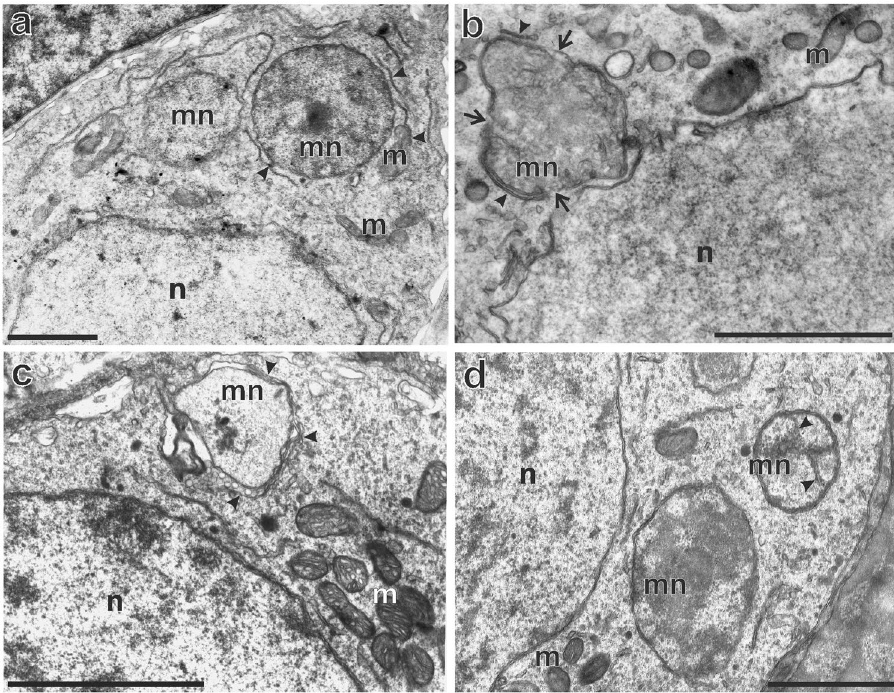
Figure 6. Chromatin in micronuclei is degraded by autophagy. Transmission electron microscopy analysis of autophagosome formation around micronuclei and invasion of tubular membranes inside the chromatin territory. Micronuclei were found in diploid hybrid males ( a ) and females ( b – d ) during the premetamorphosis stage of somatic development according to Gosner (1960), ( a – d ) stages 37, 41, 31, 36 respectively. ( a ) Sequestration of the cytoplasm by lipid double membranes (arrowheads) surrounding large heterochromatinized, intact micronucleus. ( b ) Micronucleus accompanied by two membranes assembling on the surface (arrowheads): cap-shaped (at the bottom) and linear (upper part), inside the chromatin the invading membranes are visible. Arrows point the disruptions of nuclear envelope in micronucleus ( c ) Autophagosome membranes (arrowheads) encapsulating micronucleus are partially double- or single layered. Vacuolar spaces are signs of degeneration (white spaces) and vesicles similar to lysosomes are visible. ( d ) Micronucleus with tubular membranes invading chromatin. n – nucleus, m – mitochondria, mn – micronucleus. Scale bars 2 µ